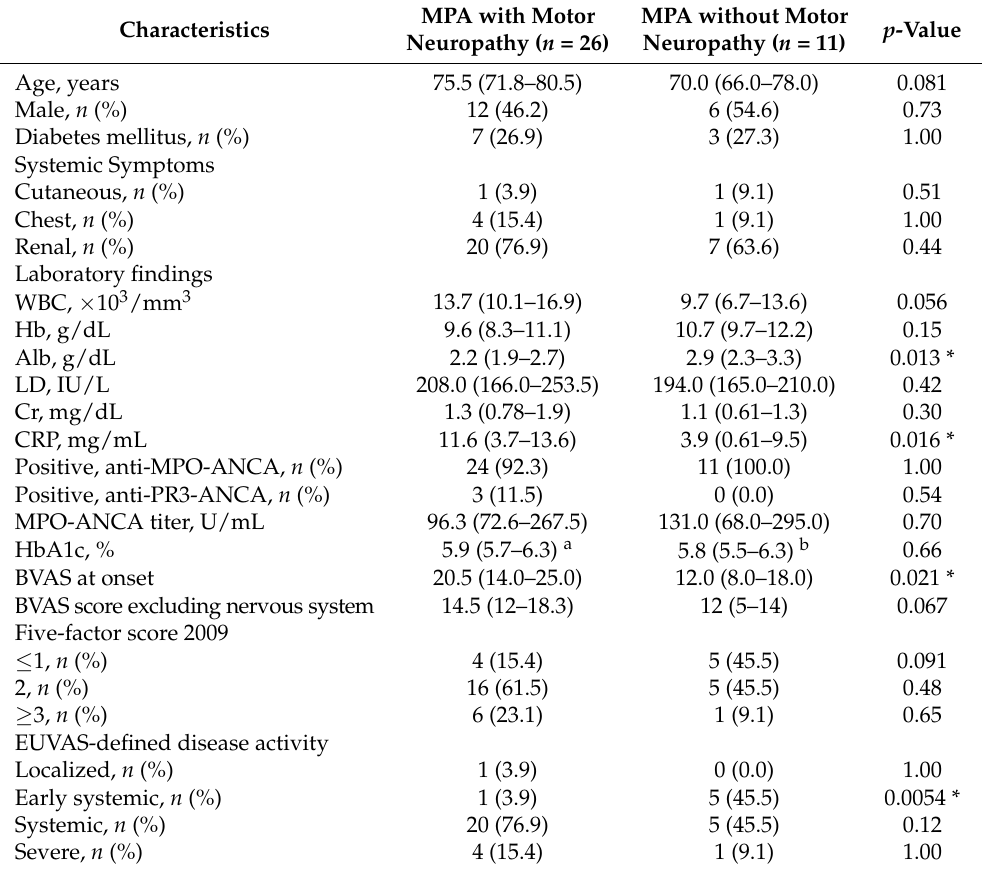
Table 4. Comparison of clinical characteristics between patients with MPA with and without motor neuropathy.